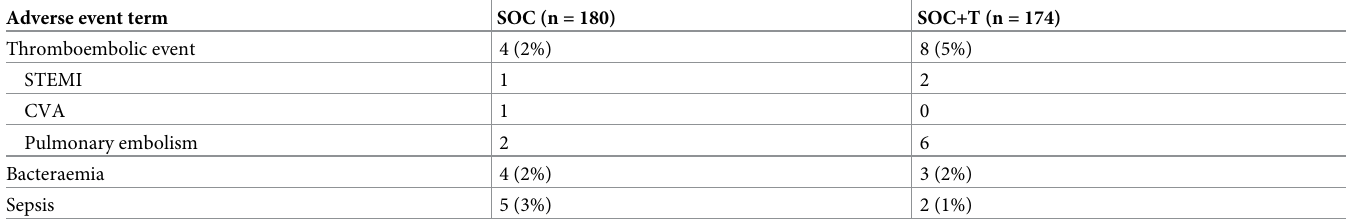
Table 3. Adverse